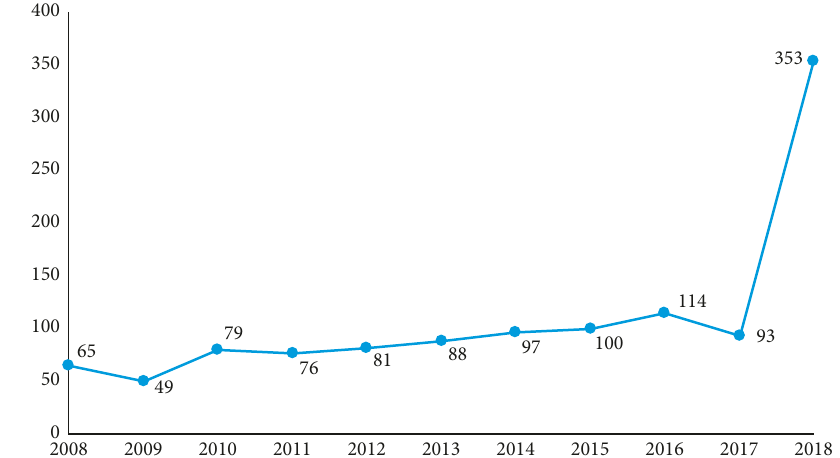
Figure 2: Number of journal articles published from 2008 to 2018.